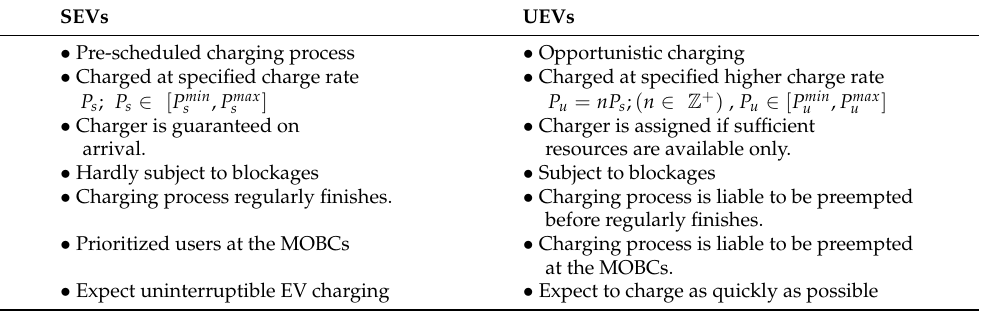
Table 1. Access privileges and constraints of EV users.